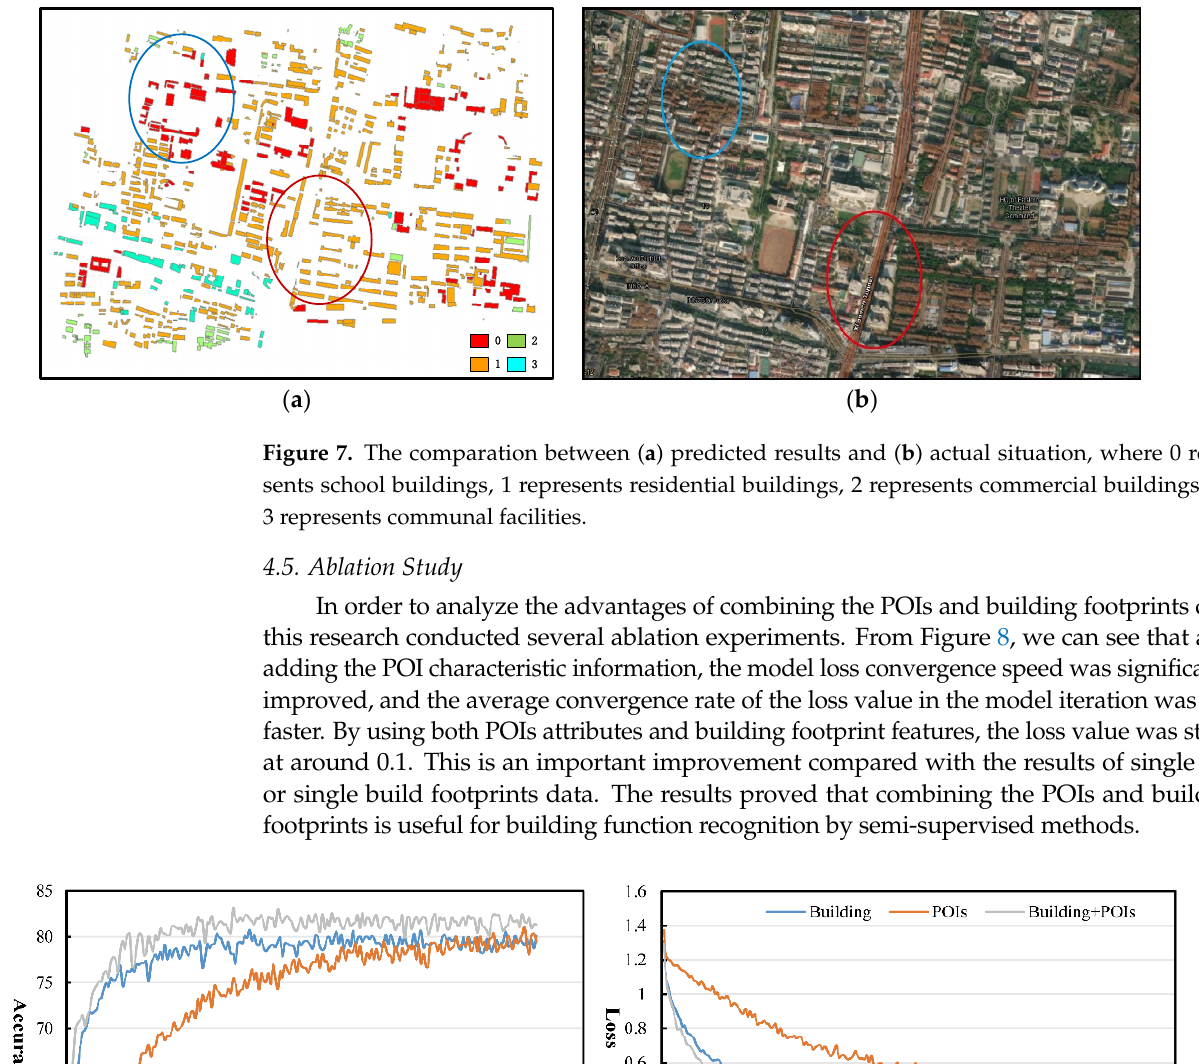
Figure 6. The confusion matrix for the classification results of UniMP on the classification of the building function.